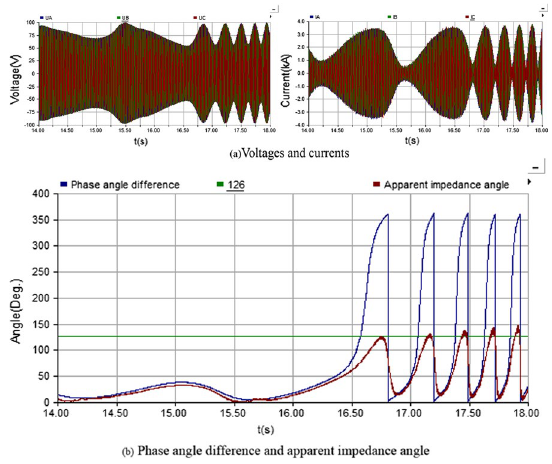
Fig. 5 Related electric quantities of the device installation point